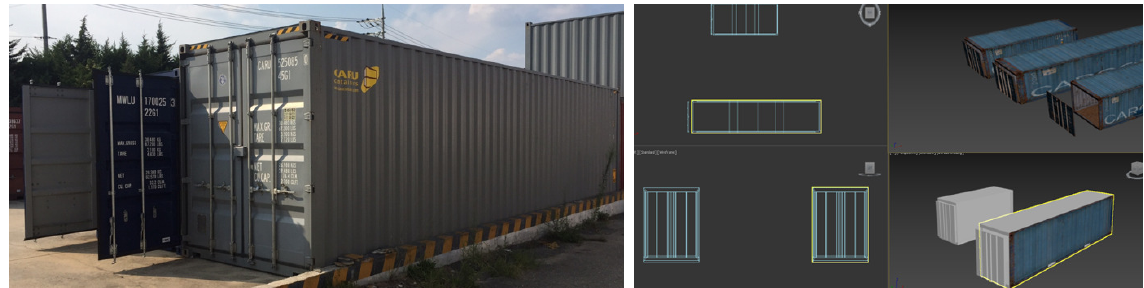
Figure 8. Test bench for the ILMS system.